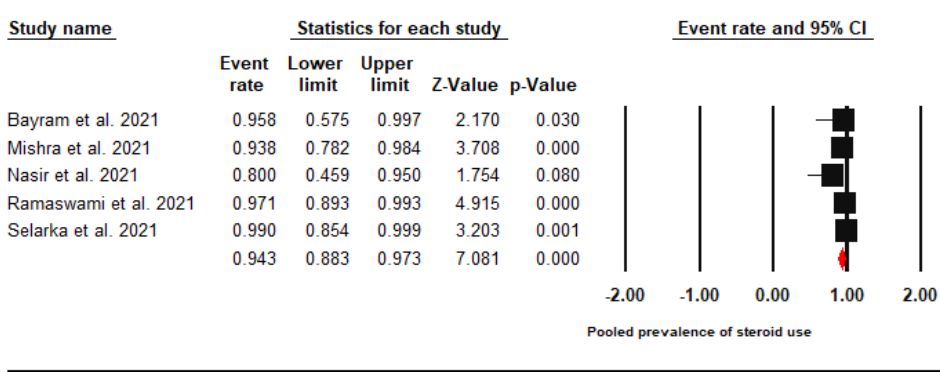
Figure 4. Forest Plot of the Pooled Prevalence of Steroids Use among CAM Patients.